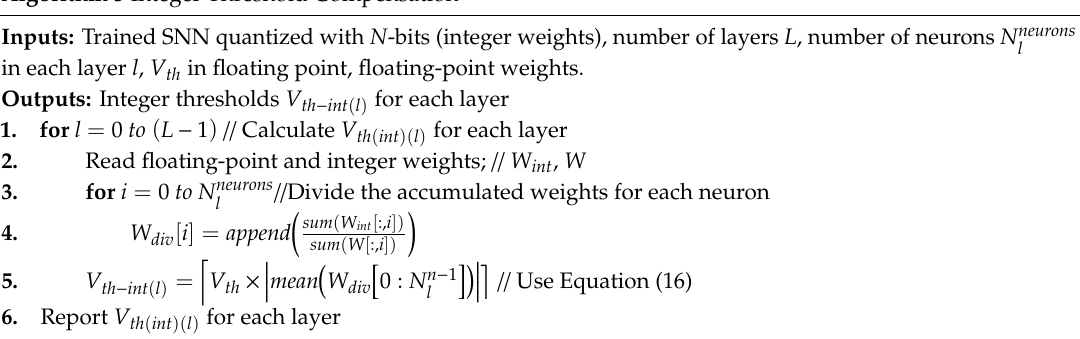
Algorithm 3 Integer Threshold